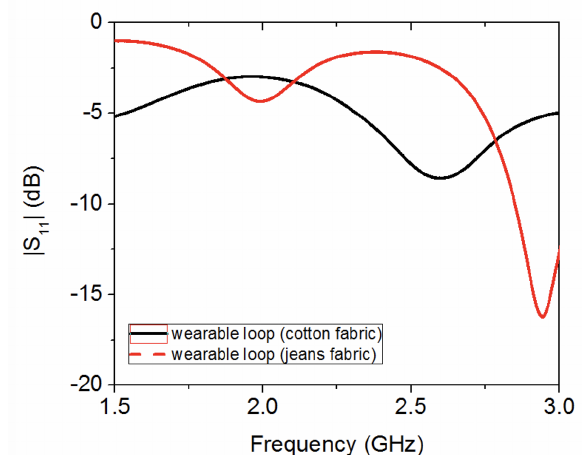
Figure 12. Measured reflection coefficient for two textile wearable loop antennas with metallic ground sheets.